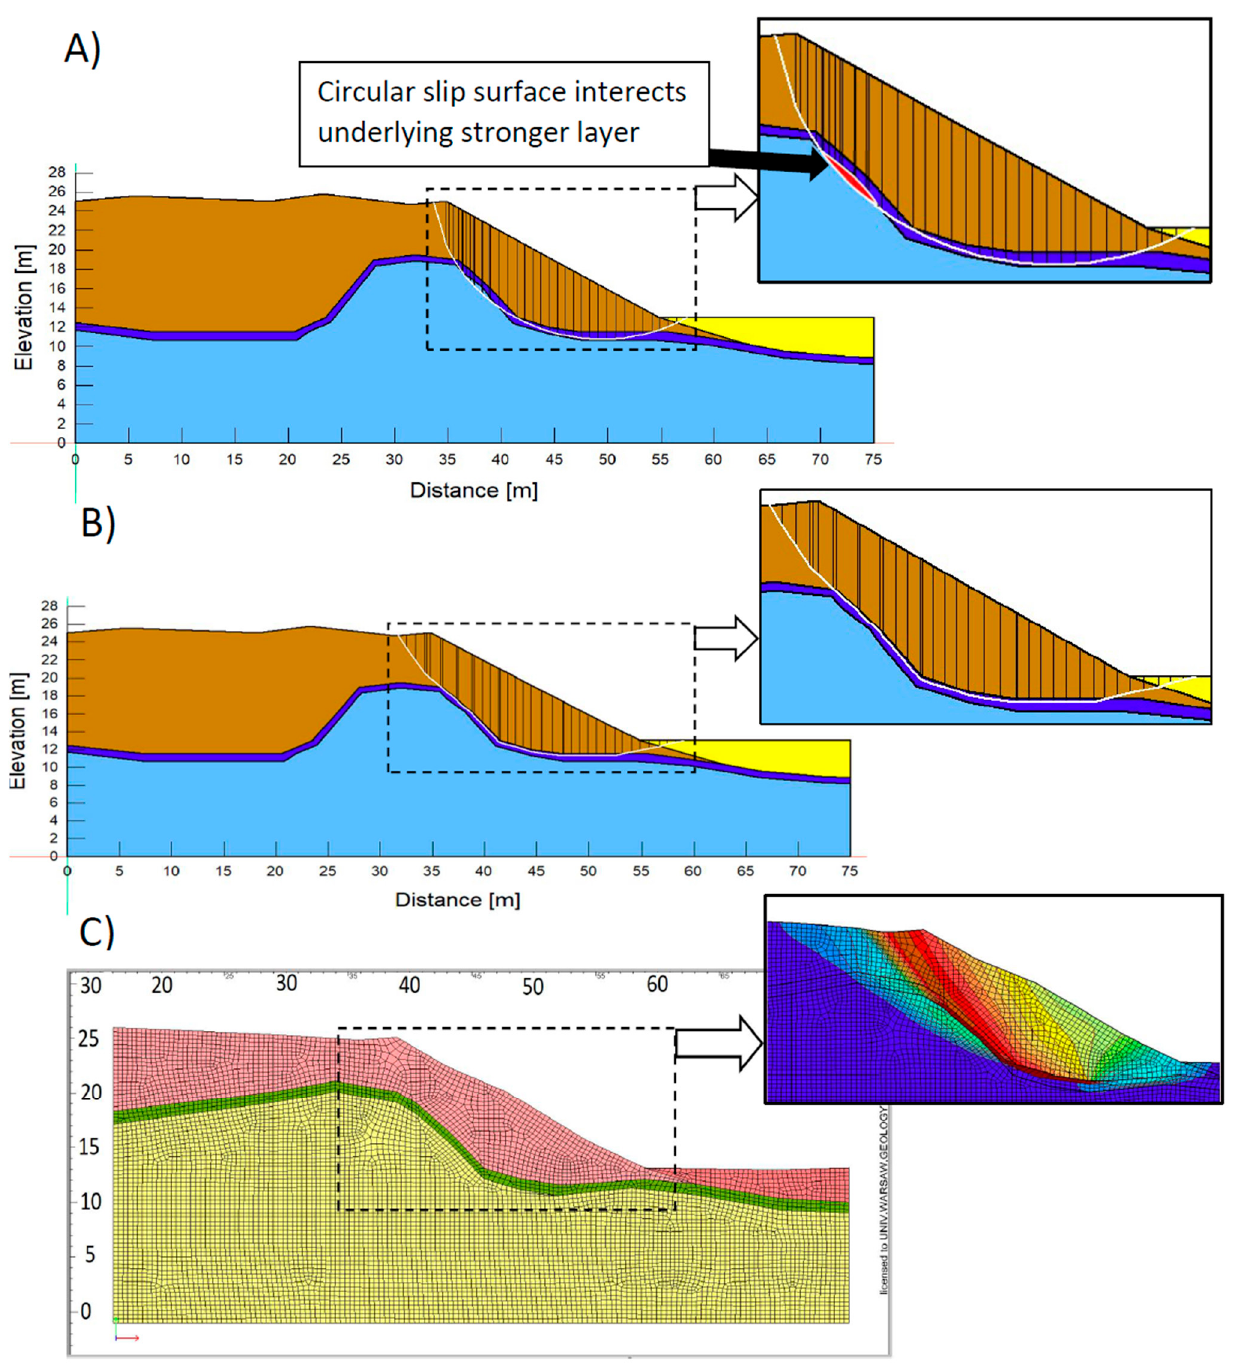
Figure 5. ( A ) Circular slip surface for Bishop’s method; ( B ) fully specified slip surface for Janbu’s method; ( C ) FEM 2D.